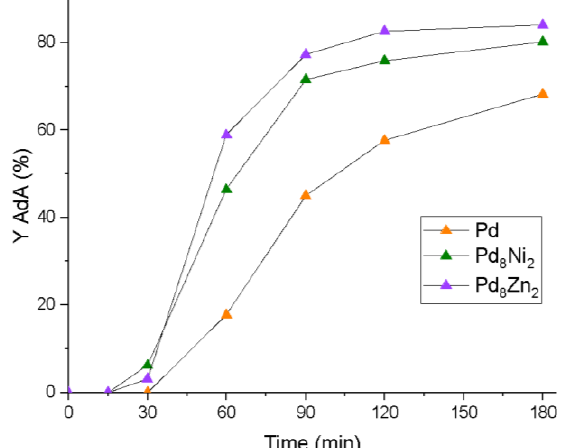
Figure 1. AdA production over the time for each of the catalysts. Reaction conditions: MA concen- tration 0.1 M, temperature 70 °C, 2 bar pressure of H 2 , metal/substrate ratio 1/500.